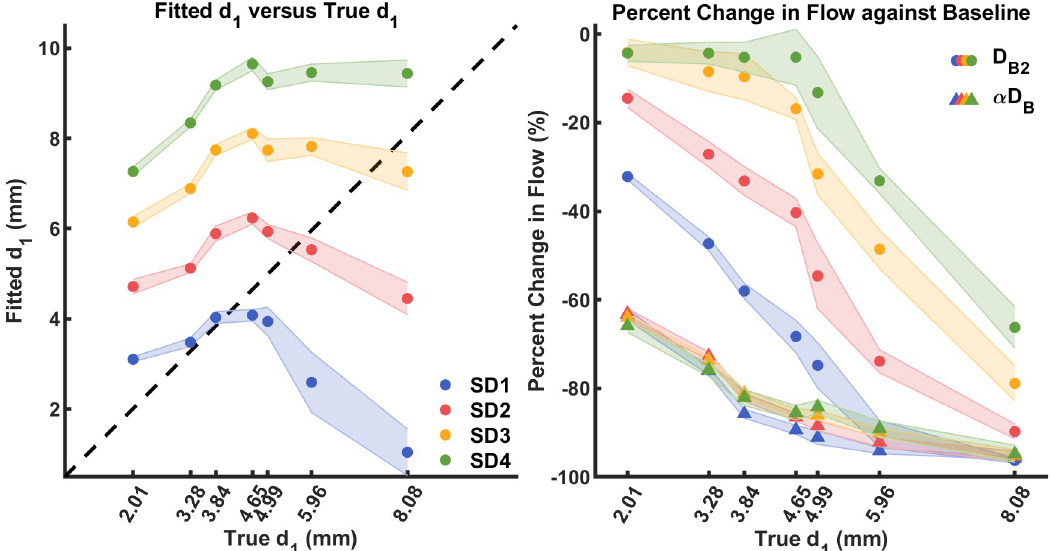
Fig 7. (a) Comparison between fitted and true d 1 for various top layer thicknesses at each SD distance. Bule: SD1 = 10 mm. Red: SD2 = 15 mm. Orange: SD3 = 20 mm. Green: SD4 = 25 mm. Mean and standard deviation of fitted d 1 were derived from ten repeated measurements. (b) Percent differences between layered phantom (P1-P7) and P0 in α D (triangle), and D using the two-layer model (circle) vs. true d 1 values. Mean and standard deviation of fitted flow were derived B 2 from ten repeated